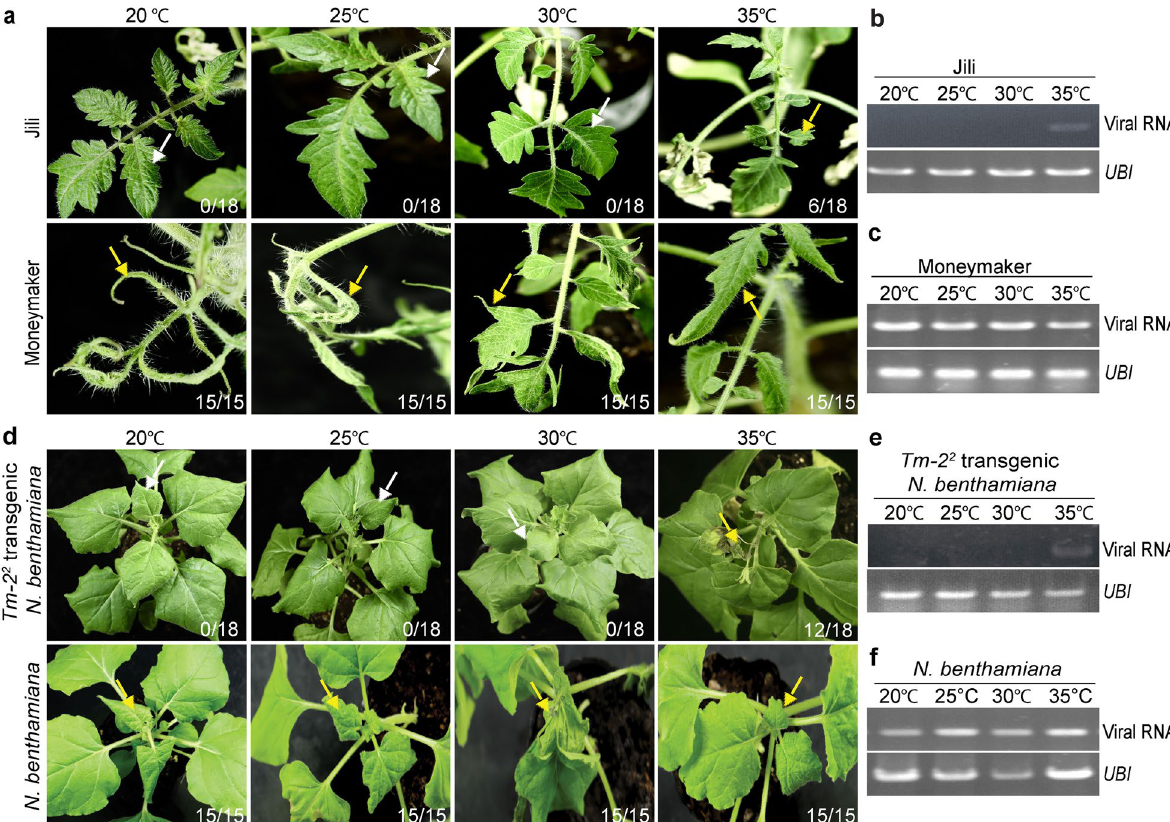
Fig. 6 Effect of temperature on the Tm-2 2 ‑mediated disease resistance against ToMMV. a The symptoms of tomato cultivars Jili (upper panel) and susceptible Moneymaker (lower panel) inoculated with ToMMV and exposed to temperatures of 20, 25, 30, and 35°C at 14 days post‑inoculation (dpi). b , c RT‑PCR detection of ToMMV RNA in systemic leaves of tomato cultivars Jili and Moneymaker respectively exposed to different temperatures. d The symptoms of Tm-2 2 transgenic (upper panel) and wild‑type (lower panel) Nicotiana benthamiana plants inoculated with ToMMV and exposed to temperatures of 20, 25, 30, and 35°C at 7 dpi. e , f RT‑PCR detection of ToMMV RNA in the systemic leaves of the Tm-2 2 transgenic and wild‑type N. benthamiana plants. The numbers in the lower right corner of each picture indicate the number of infected plants out of the total inoculated plants for three experimental repeats. The yellow arrows show symptomatic systemic leaves and white arrows